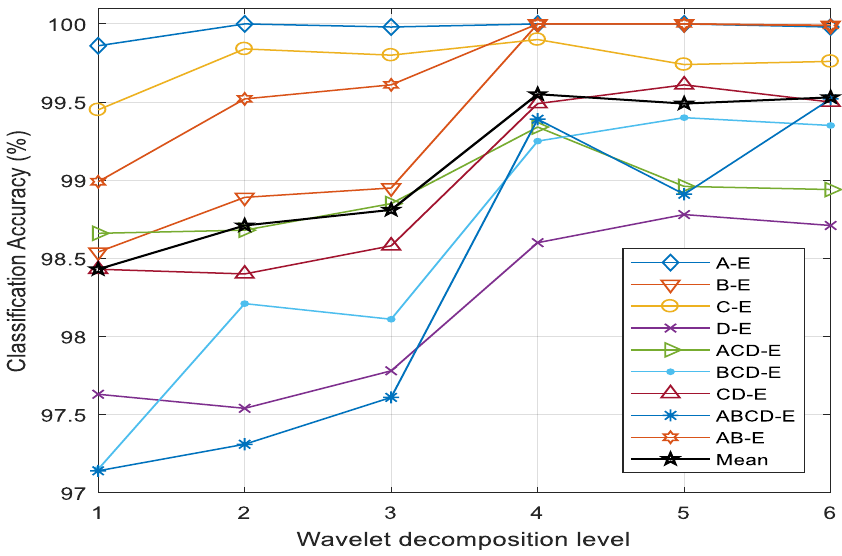
Figure 7. Classification accuracies of different cases and the mean accuracy as a function of wavelet decomposition levels to generate the subbands.